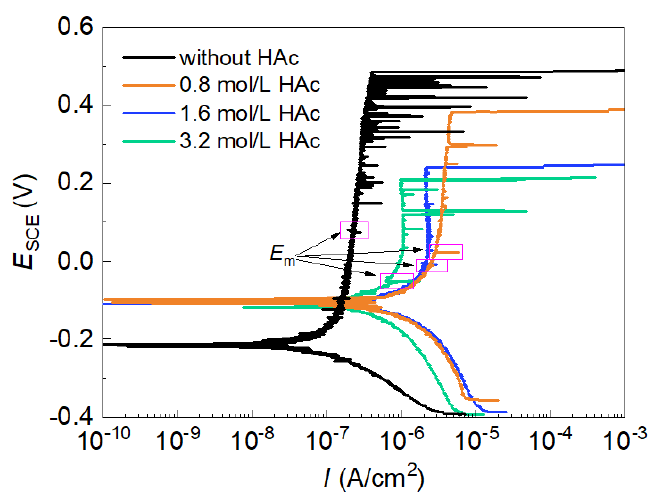
Figure 1. Polarization curves of 304 SS in 0.6 mol/L NaCl solutions with different concentrations of HAc.